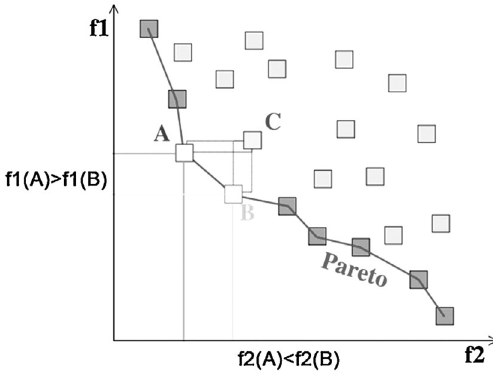
Figure 1. Pareto optimal solutions (A and B) for 2D